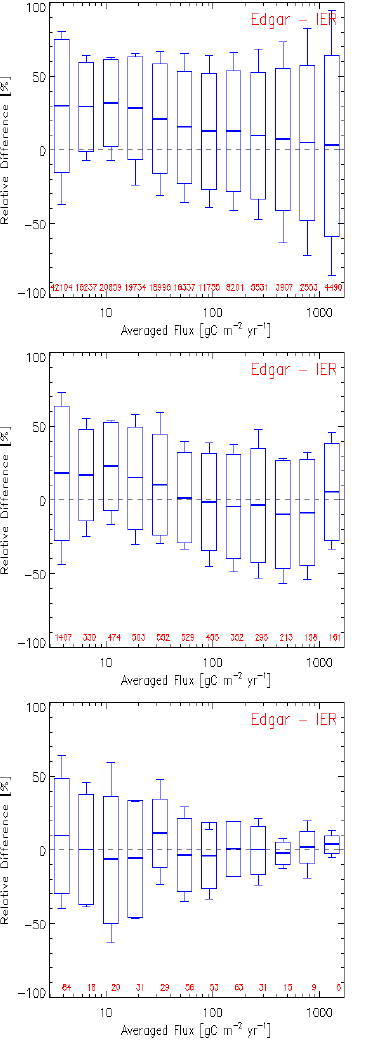
Fig. 7b. Comparison between EDGAR and IER fossil fuel emissions (g C m -2 yr -1 ) at various spatial resolutions (top to bottom: 1/12, 1/2, and 2 degrees). The right column shows the ratio of EDGAR 4.1 to IER emissions (log scale). The left column shows the binned relative difference (a-b)/(a+b) where a is the EDGAR estimate and b is the IER estimate. The thick horizontal line is the mean, the box indicates ± one standard deviation, and the whiskers indicate the 10% and 90% percentiles. Perfect agreement would have the mean and standard deviation equal to zero.